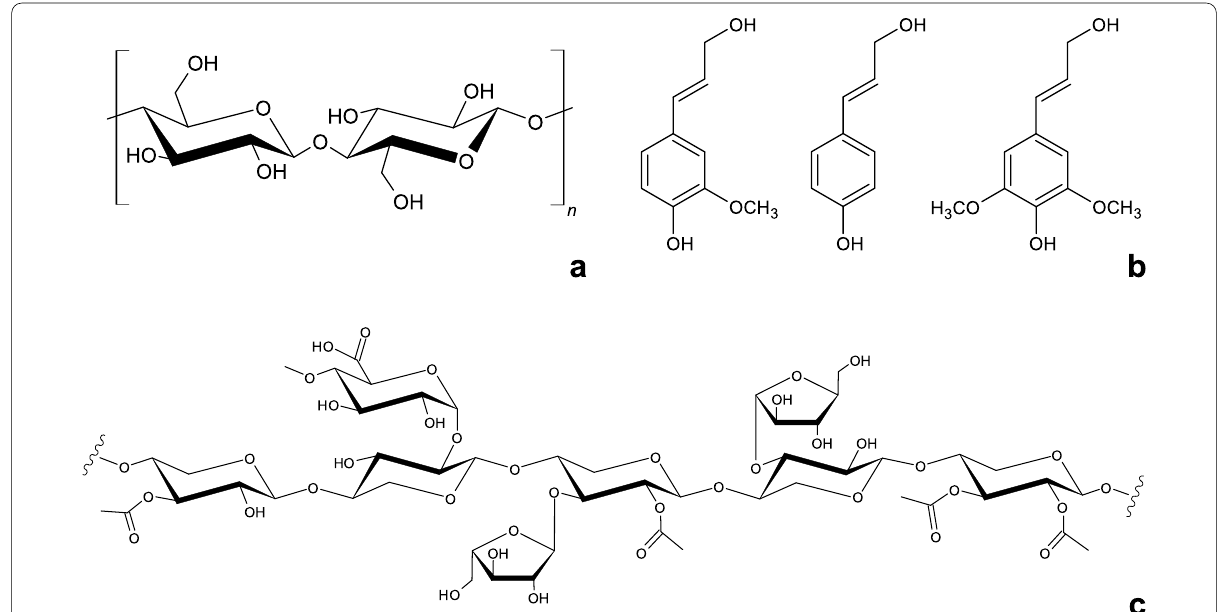
Fig. 1 Components of lignocellulose. Chemical structures of cellulose ( a ), the lignin building blocks coniferyl alcohol, p -coumaryl alcohol, and sinapyl alcohol ( b ) as well as hemicellulose from grass ( c ) adapted from Escobar et al.